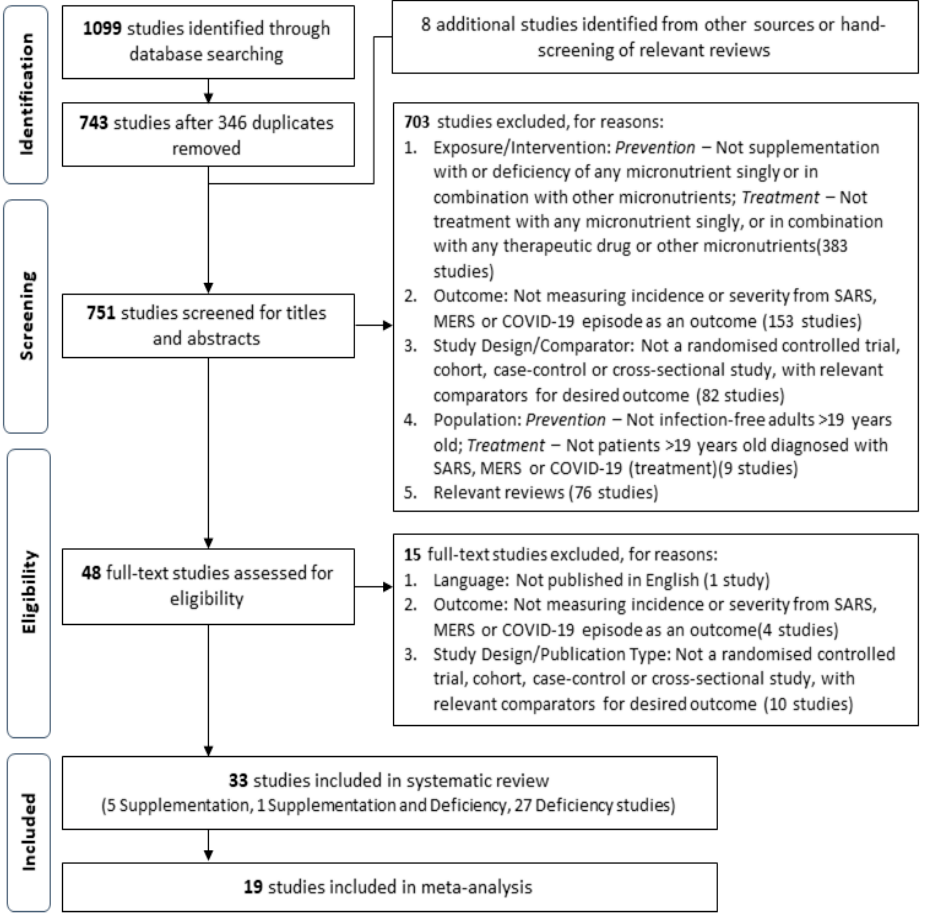
Figure 1. Flowchart of the screening and study selection process.